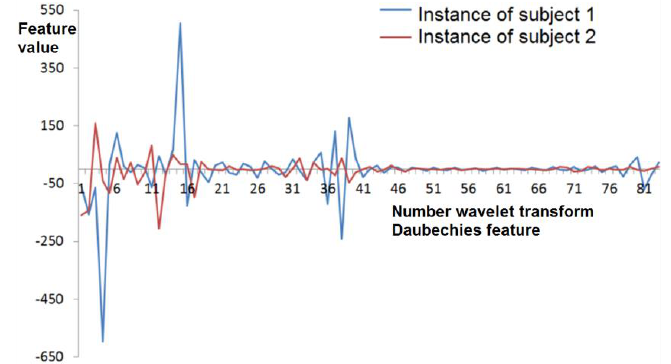
Figure 3. Wavelet transform coefficients scaled by the pen pressure function (onto a tablet) to the mean length of a signature instance for different signers.